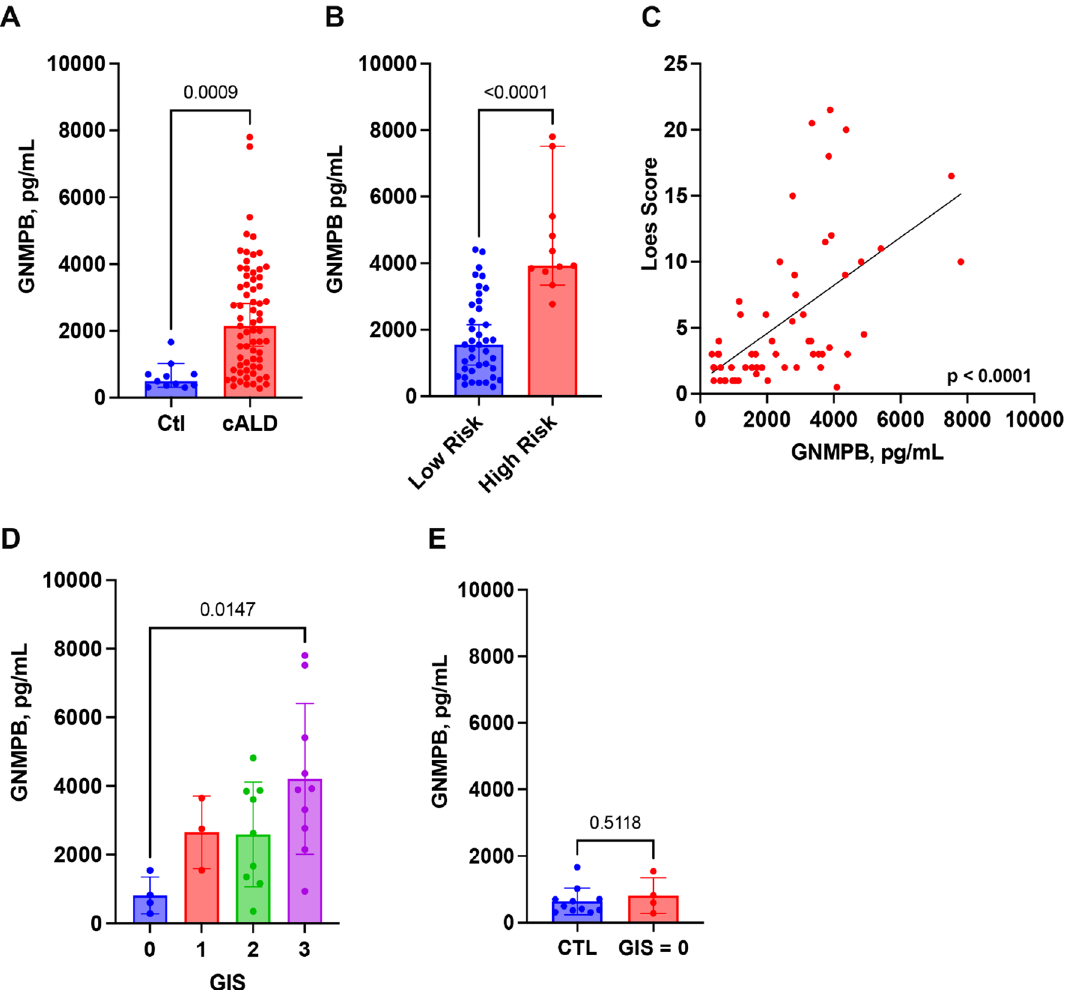
Figure 1. CSF GNMPB levels are elevated in boys with cALD. ( A ) shows levels of CSF GNMPB. ( B ) shows the difference between low risk and high-risk boys based on a Loes score cutoff of ≥ 10. ( C ) shows Loes score as a continuous variable and p -value derived from a linear regression analysis. ( D ) shows the comparison of CSF GNMPB amongst cALD patients categorized by GIS. Two-comparisons shows p -values derived from a Student’s t-test. P -value in ( D ) was derived from an ANOVA and Tukey post-hoc test. The main effect p-value was p = severity 19 . Genetic treatment of Gaucher in mouse models, or treatment of humans by enzyme replacement